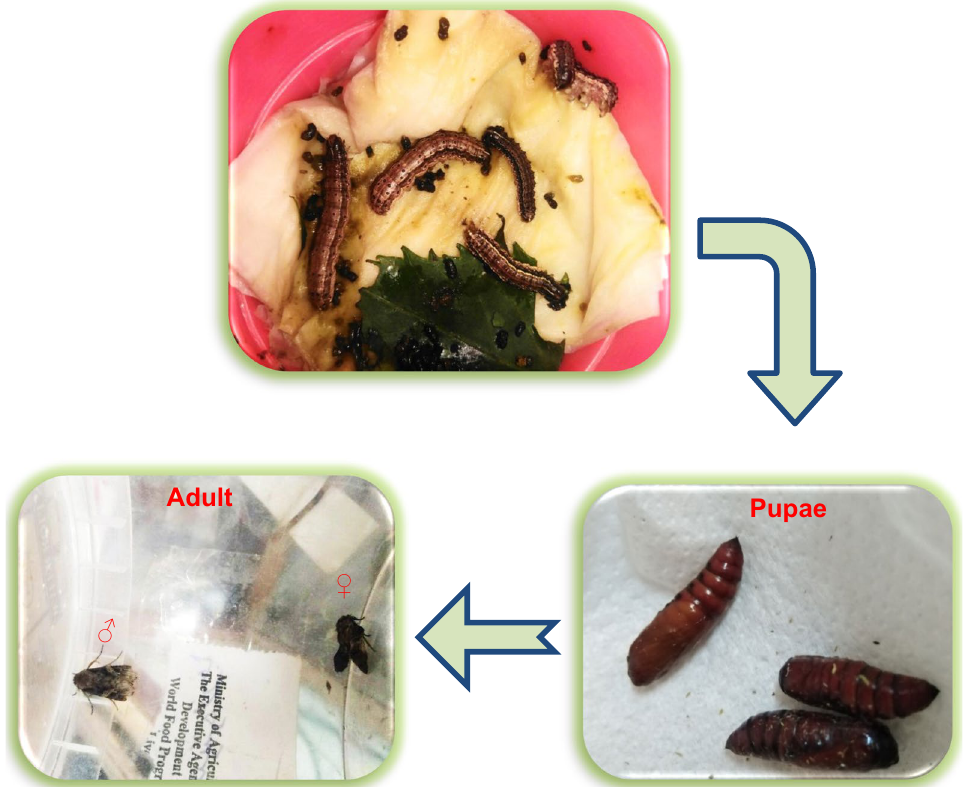
Fig. 4 Larvae succeeded to complete their development after the application of Heterorhabditis indica at low IJs nematode concentration, showing male moth with slightly wing curled, but female with completely wing malformation